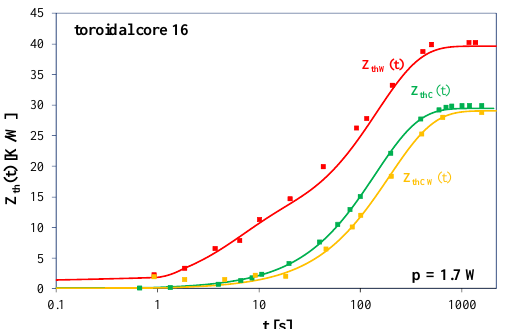
Figure 10. Measured and calculated waveforms of transient thermal impedances of the inductor containing the medium cup core.